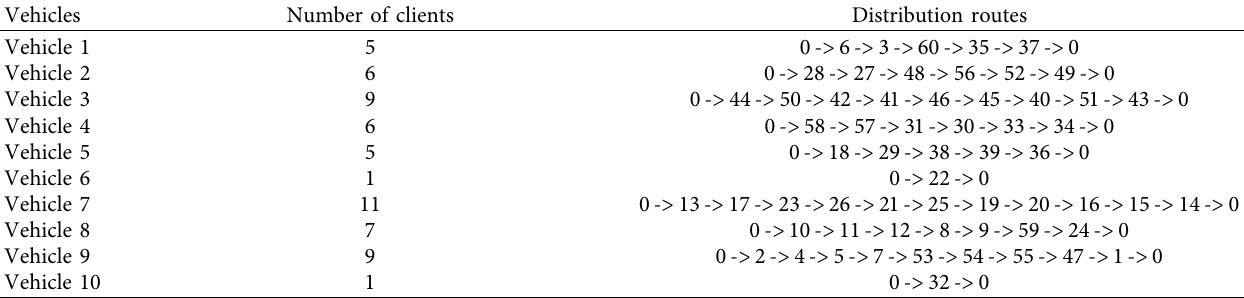
Table 4: Distribution path by genetic algorithm.